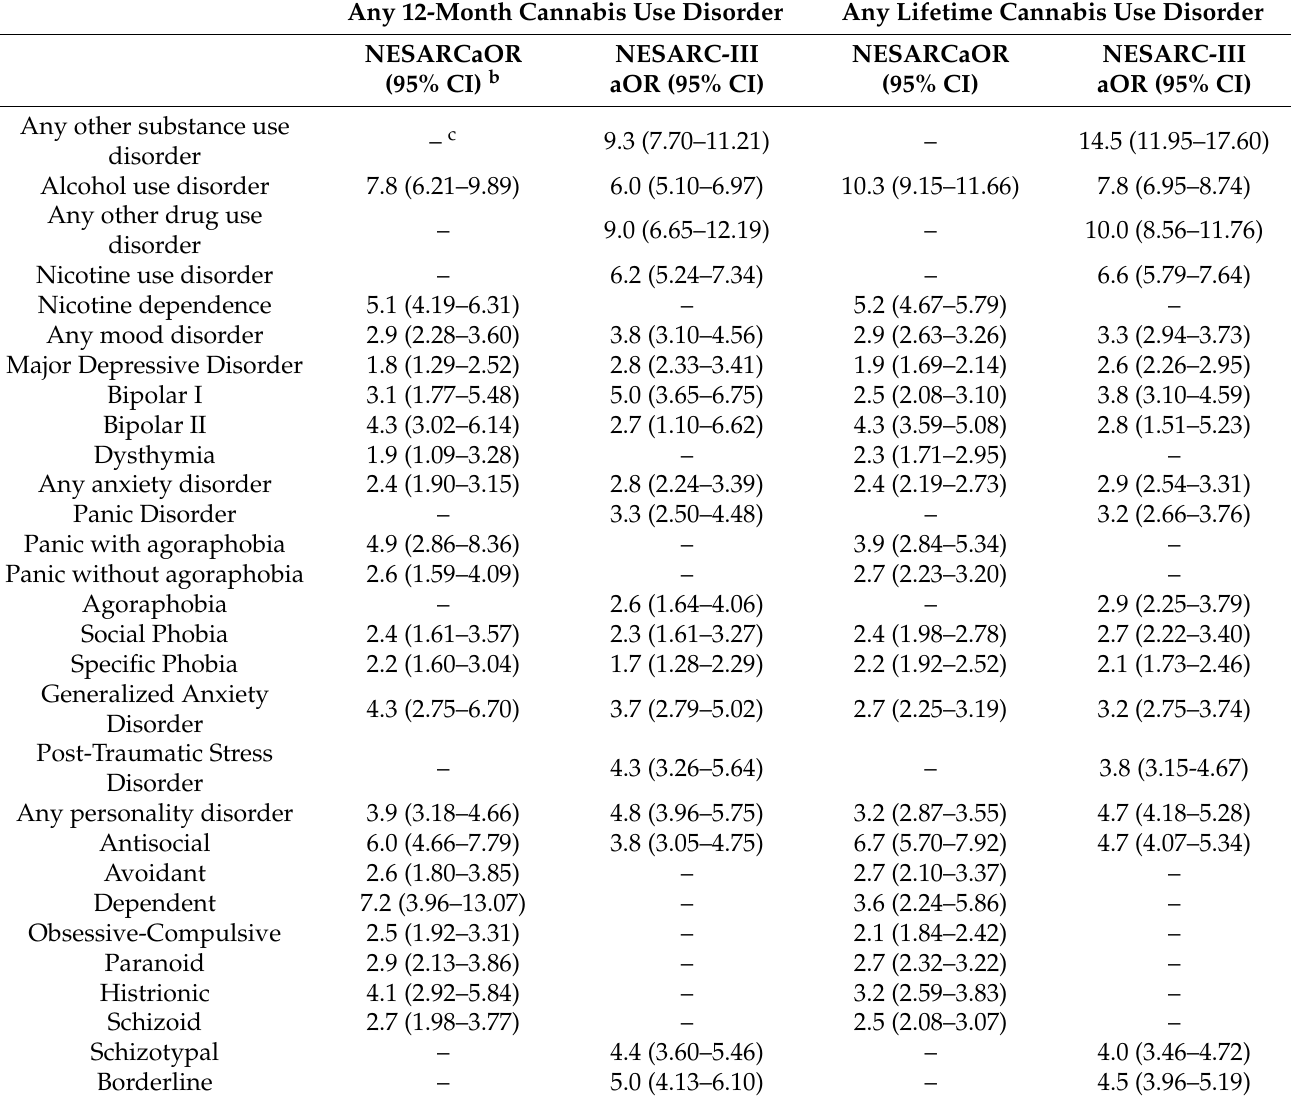
Table 1. Adjusted Odds Ratios (aORs) a indicating the association of CUD with a psychiatric disorder National Epidemio- logic Survey on Alcohol and Related Conditions (NESARC) 2001–2002 and NESARC-III